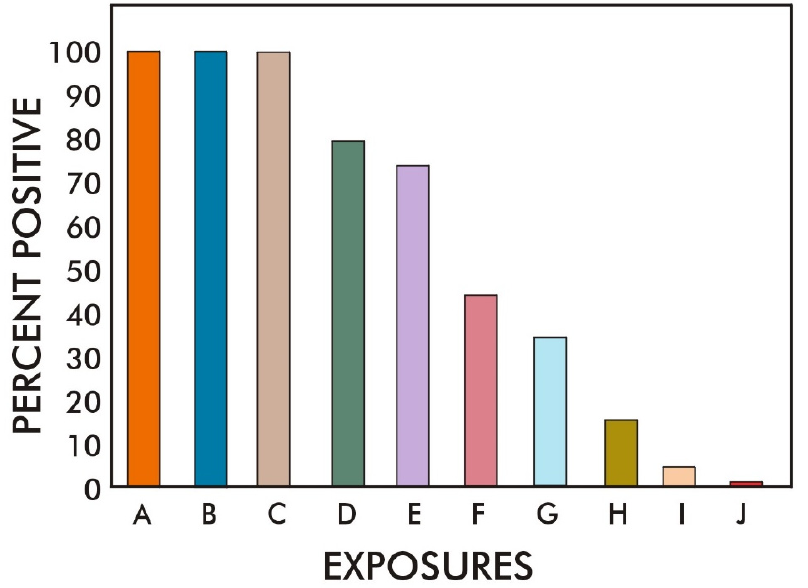
Figure 2. Trial participant-reported exposures during the 1991 Gulf War. Percent of trial participants exposed to: A: direct fuel and/or oil, B: smoke from burning oil wells, C: smoke from burn pits, D: ingestion of pyridostigmine bromide, E: exposure to pesticides, F: exposure to raw sewage, G: exposure to insects, H: direct contact with dead bodies, I: presumed exposure to chemical warfare agents, and J: exposure to herbicides.